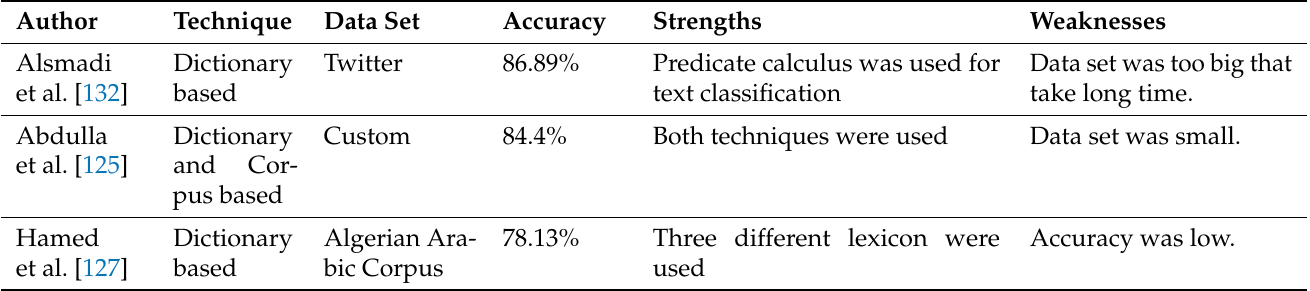
Table 5. Comparison of Lexicon based techniques used for Arabic text